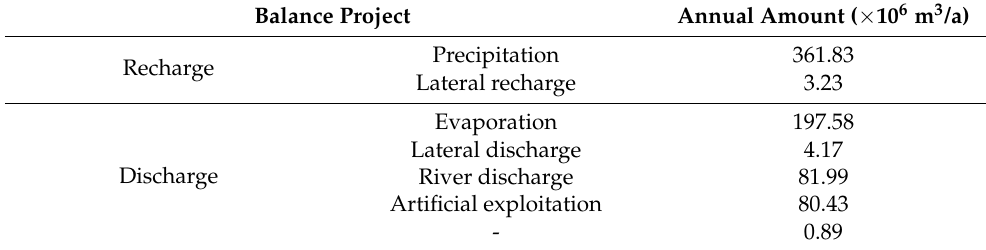
Table 3. Results of groundwater budget in the study